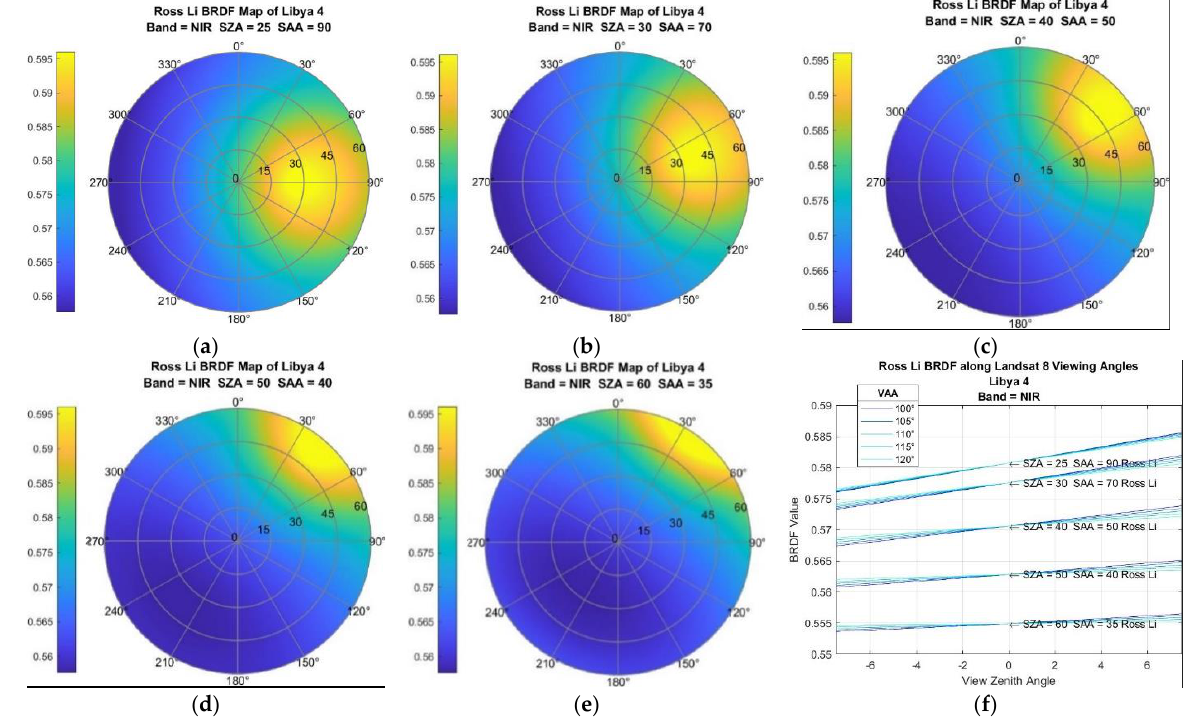
Figure 1. ( a – e ): BRDF models of grass pasture for different SZA and SAA locations. Note how hot spot follows solar location as the sun moves lower in the sky. ( f ): Linearity of BRDF versus VZA for entire range of Landsat viewing angles. Note how the slope is greater as the sensor view angle moves closer to the “hot spot”. Image source: [5].